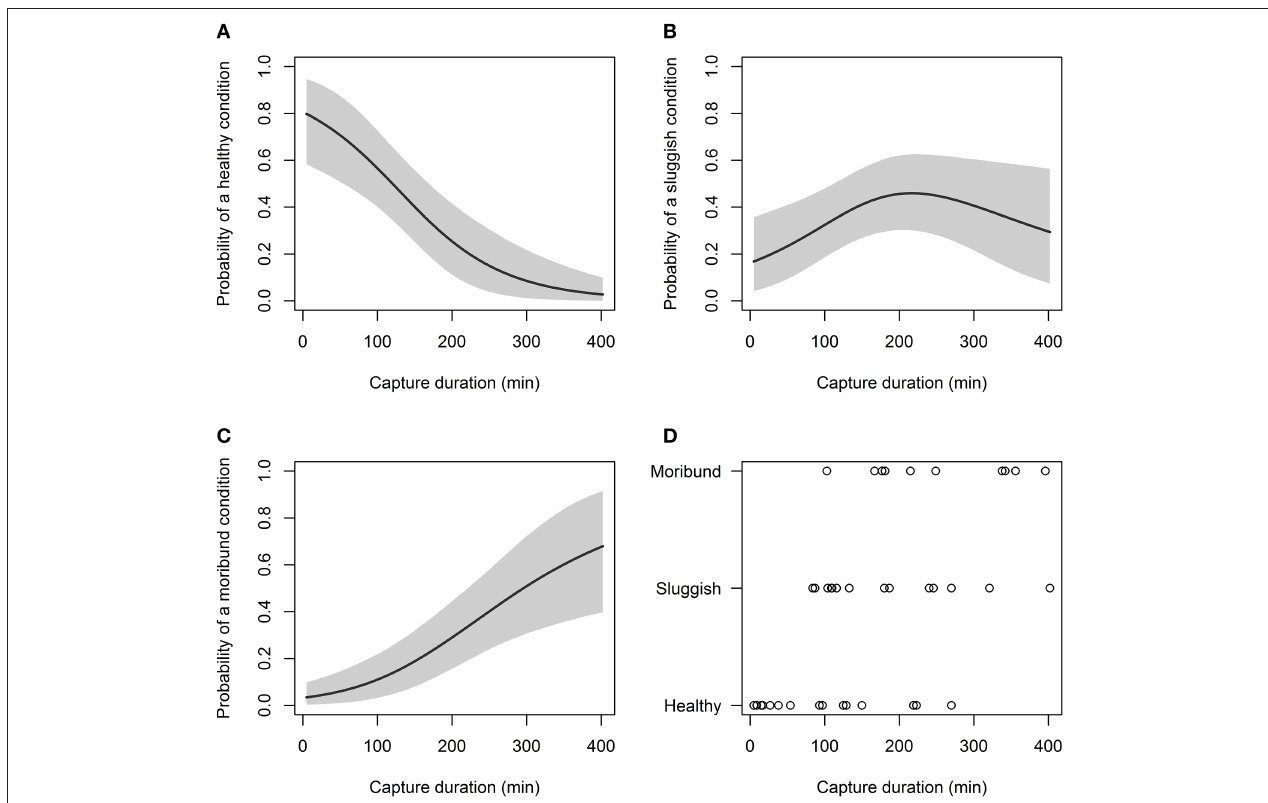
FIGURE 4 | Probability of a C. brachyurus being boated in a certain condition (A – “healthy,” B – “sluggish,” C – “moribund or dead”) given capture duration. Gray shading in (A–C) represents 95% credibility intervals. (D) Plots the raw data vs. capture duration, sorted by category (“healthy,” “sluggish,” and “moribund or dead”). The mean capture durations for captured sharks in “healthy,” “sluggish,” and “moribund or dead” conditions were 98, 185, and 252min,